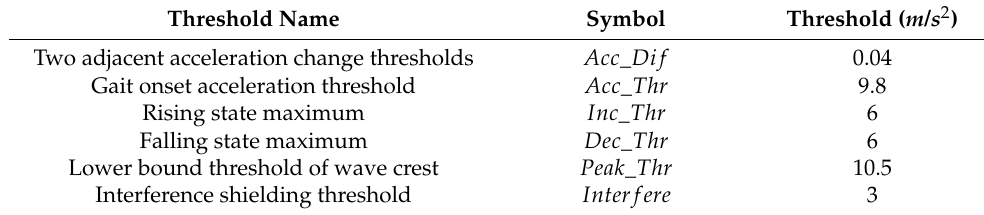
Table 1. Empirical parameters in the gait-detection algorithm.